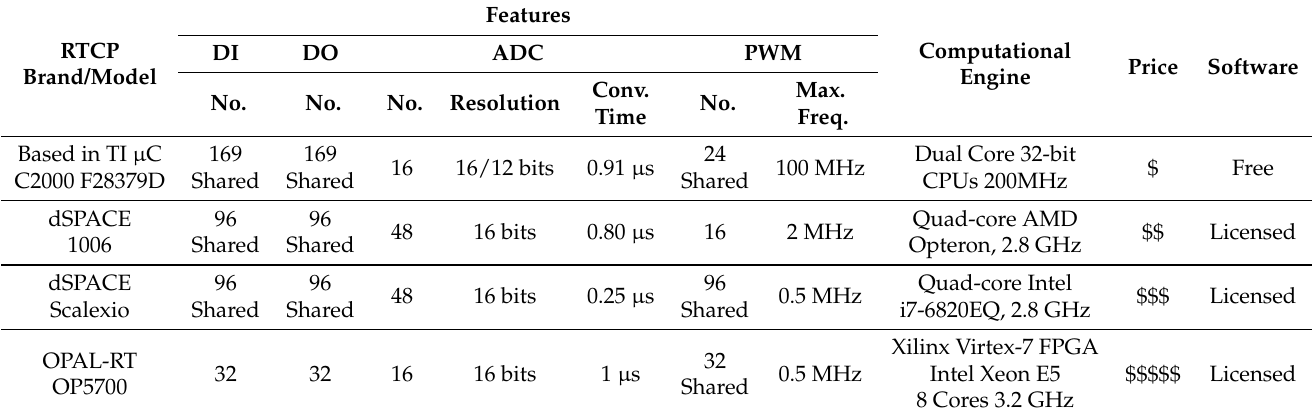
Table 1. Technical benchmarking of the RTCPs used in this